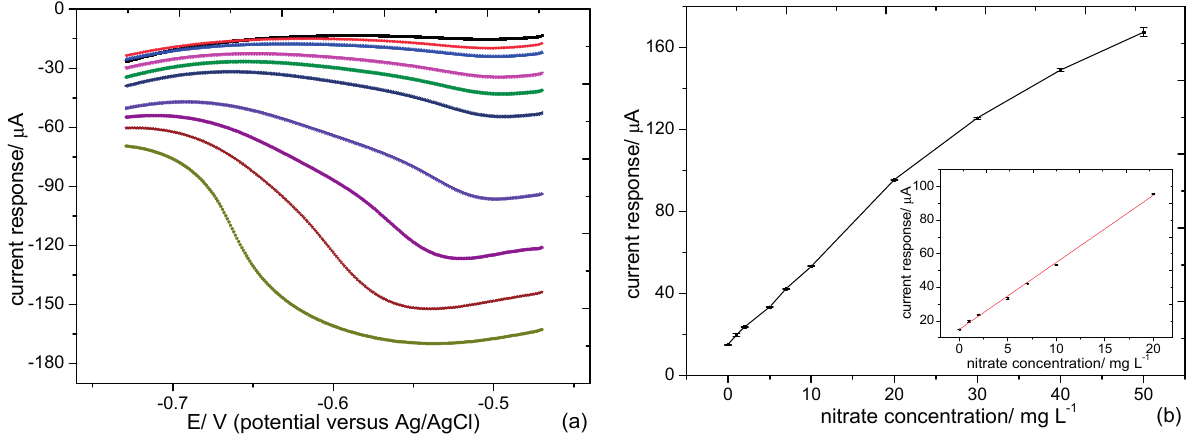
Figure 7. ( a ) Linear sweep voltammograms detailed the determination of